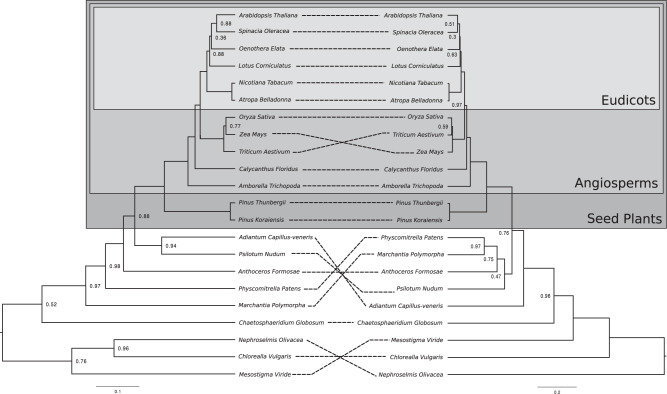
Phylogenetic reconstruction of plant plastid sequences, based on the psaB  protein-coding gene; unlabeled nodes have \documentclass[12pt]{minimal}
\usepackage{amsmath}
\usepackage{wasysym} 
\usepackage{amsfonts} 
\usepackage{amssymb} 
\usepackage{amsbsy}
\usepackage{upgreek}
\usepackage{mathrsfs}
\setlength{\oddsidemargin}{-69pt}
\begin{document}
}{}$>$\end{document}0.9999 posterior probability. Left: MCC tree based on a standard GTR+ASRV model. Right: MCC tree based on an MMM(GTR)\documentclass[12pt]{minimal}
\usepackage{amsmath}
\usepackage{wasysym} 
\usepackage{amsfonts} 
\usepackage{amssymb} 
\usepackage{amsbsy}
\usepackage{upgreek}
\usepackage{mathrsfs}
\setlength{\oddsidemargin}{-69pt}
\begin{document}
}{}$_{33A}$\end{document} with ASRV, which is strongly supported over the MCC tree generated under the GTR model (log Bayes factor of 347). While only a single different clustering can be observed within the Angiosperms, many differing clusters that have very high posterior probabilities are generated using the MMM(GTR)\documentclass[12pt]{minimal}
\usepackage{amsmath}
\usepackage{wasysym} 
\usepackage{amsfonts} 
\usepackage{amssymb} 
\usepackage{amsbsy}
\usepackage{upgreek}
\usepackage{mathrsfs}
\setlength{\oddsidemargin}{-69pt}
\begin{document}
}{}$_{33A}$\end{document} outside of the seed plants.